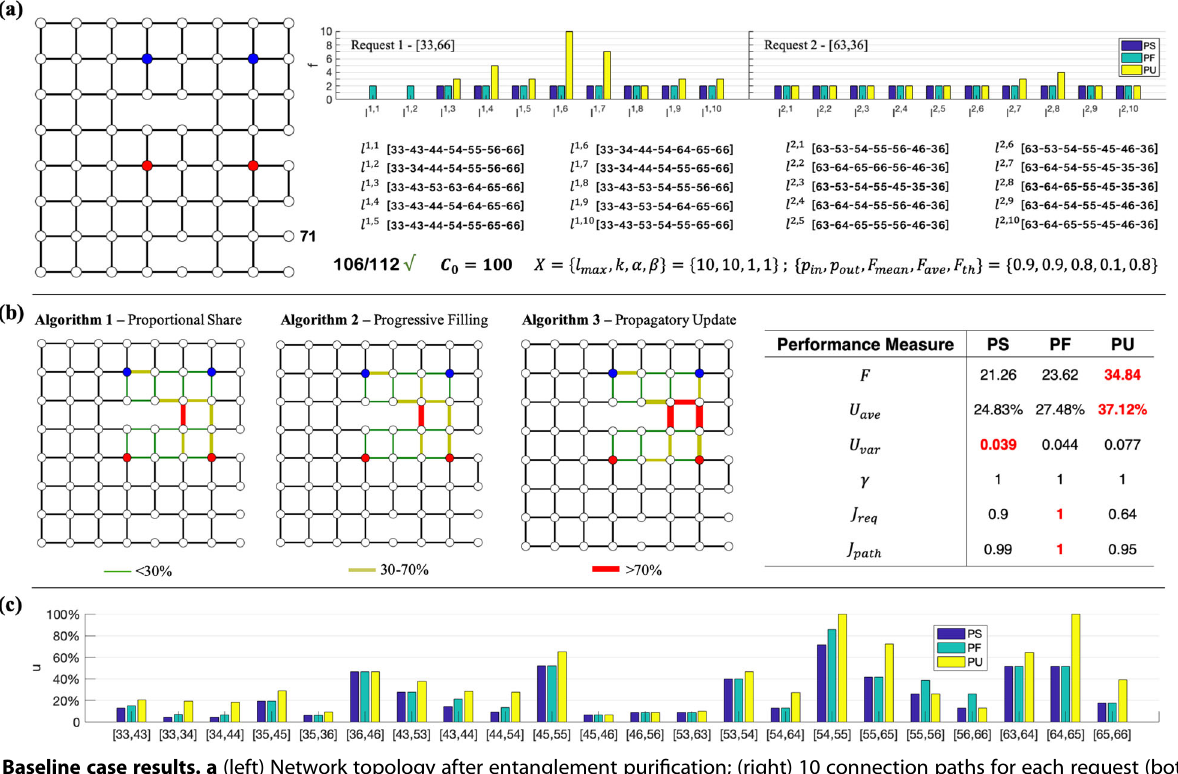
Fig. 4 Baseline case results. a (left) Network topology after entanglement puri fi cation; (right) 10 connection paths for each request (bottom) and the allocated fl ow for each path under the three scheduling schemes (top). Here the nodes are represented by a two digit number and the bottom left corner is denoted as 00. An example of node 71 is labeled in the graph plot. b Comparison of routing performance. Traf fi c plots (left) and performance measures (right). We show the traf fi c plot in a 8-by-8 network where edge color and width represent the capacity utilization of the corresponding edge (<30% in green, 30 – 70% in yellow and >70% in red, large width corresponds to larger utilization). c Capacity utilization on (utilized) edges under the three schemes. For simplicity sake, in all simulations hereafter we set the initial capacity of each edge to be C 0 = 100, and the fi delity distribution among edges follows a normal distribution with mean F mean = 0.8 and standard derivation F std =